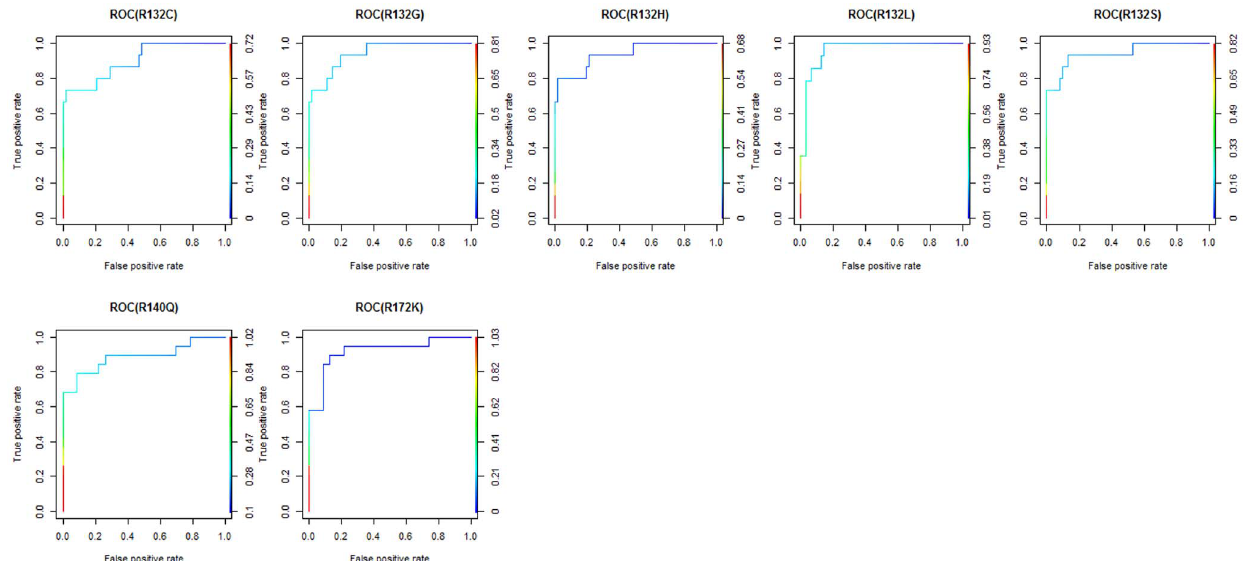
Figure 2. ROC curves for all mutants. TPR-true positive rate; FPR-false positive rate.